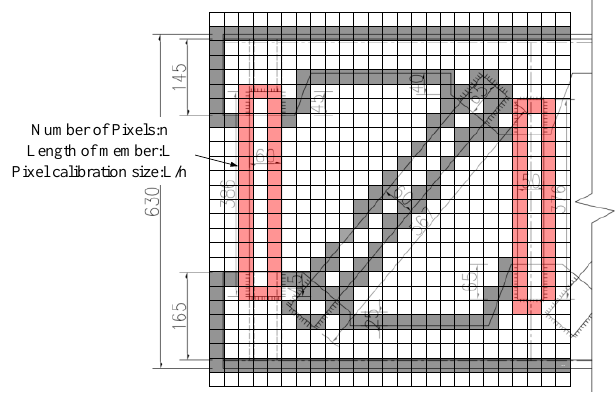
Figure 13. Pixel calibration schematic. Table 3. Pixel size calibration table of vertical members.